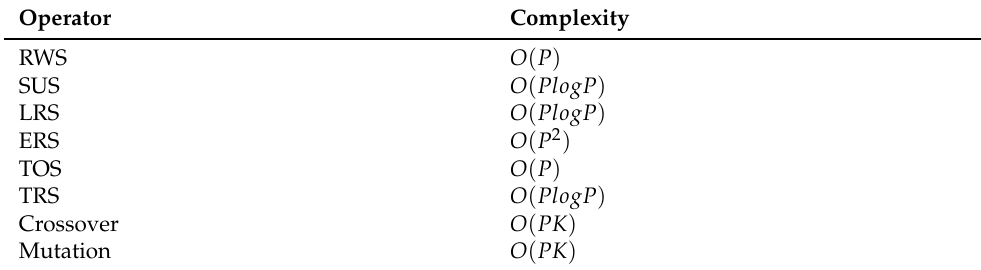
Table 2. Complexity of different GA